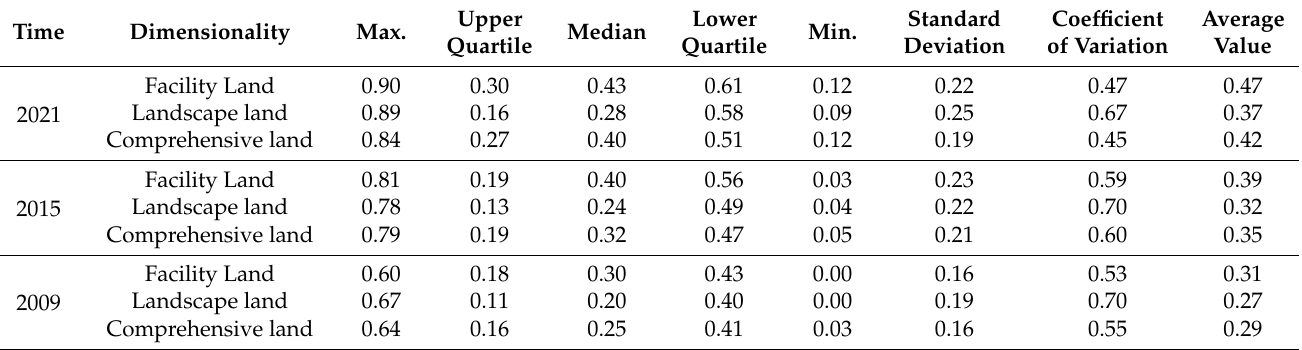
Table 1. Descriptive statistics of the overall level of rural tourism land in the study area.